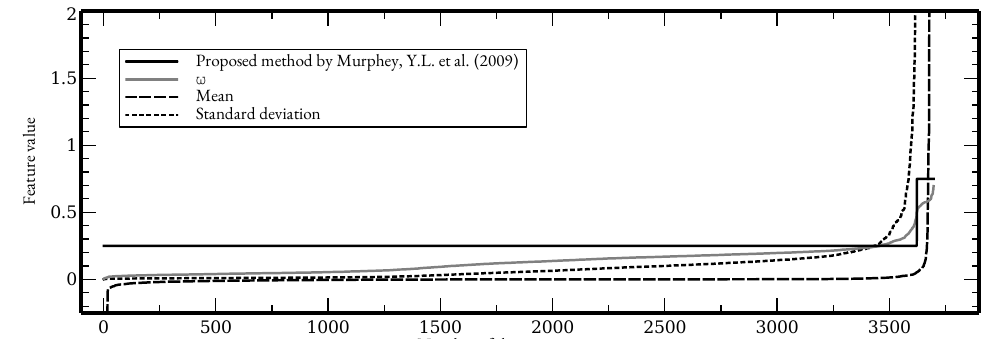
Figure 2. The sorted values of mean, standard deviation, the feature proposed by [25], and our proposed feature for all preprocessed movement patterns from [24]. The approach from [25] only yields two distinct classes and cannot detect noise. On the other hand, the curve representing the mean is almost flat, meaning it is very difficult to distinguish different clusters. The standard deviation depicts a similar behaviour to that of our proposed feature, but bears a less stable behaviour towards the end. Our feature yields a curve with a clear monotonic increase and a notable elbow at the end. Thus, we obtain the same segregation ability as the standard deviation but a clearer threshold for noise detection, which is given by the samples located in the